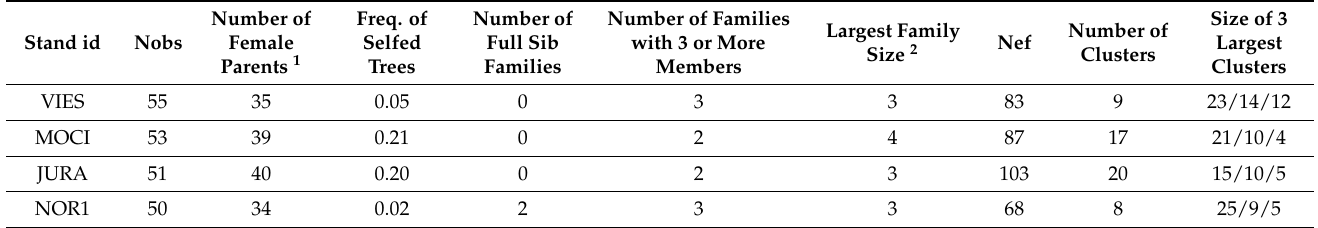
Table 6. Sibling structure analysis in four European beech stands (soft. COLONY). Nef is effec- tive population size. Nobs is number of trees. Spatial arrangement of the clusters is shown in Supplementary